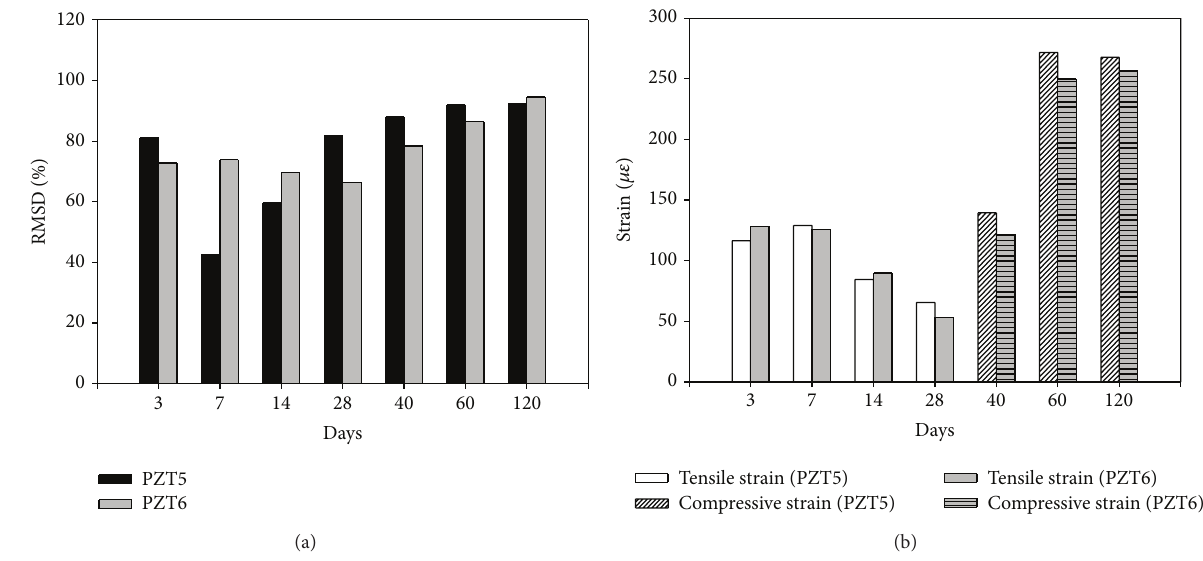
Figure 21: Comparison of PZT5 and PZT6: (a) RMSD value and (b) strain of concrete around EMI sensors.